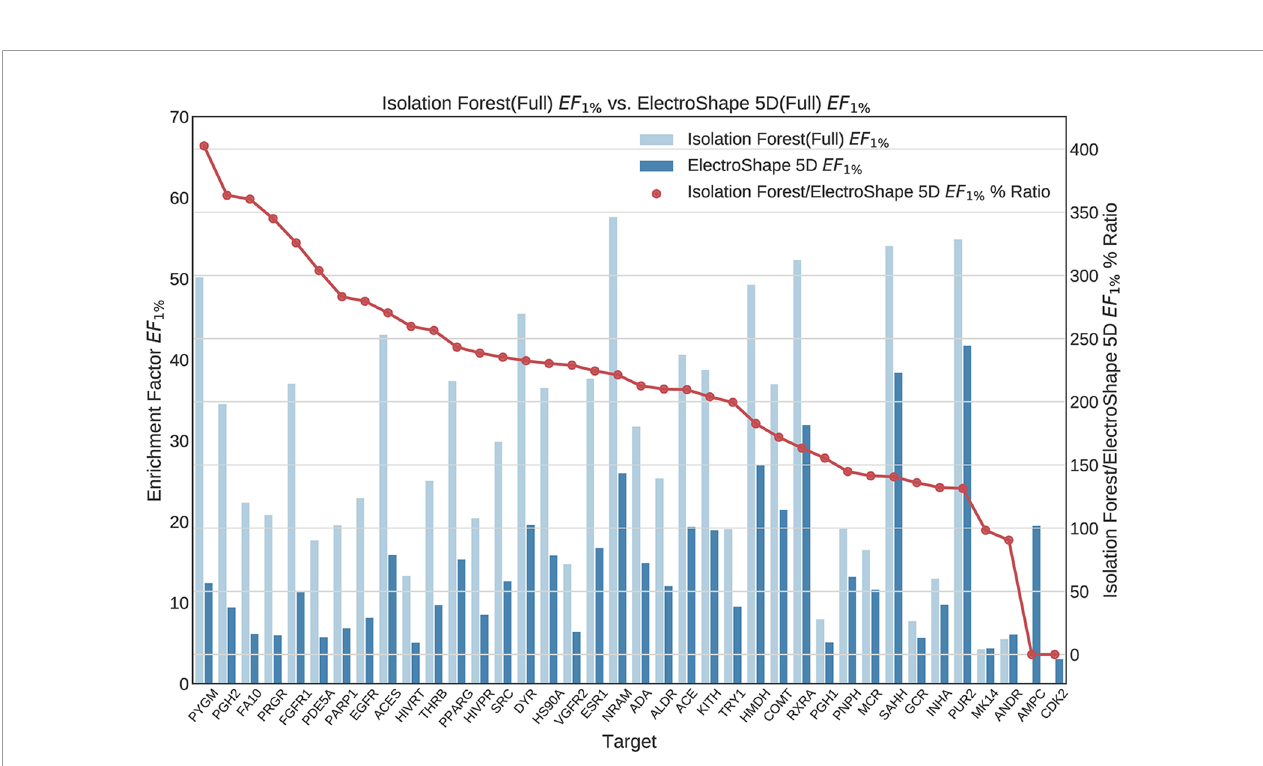
FIGURE 7 | Comparison of Enrichment Factor at 1% obtained by Isolation Forest with that obtained by ElectroShape 5D using full conformer model. Also plotted is the percentage ratio of the Enrichment Factor score of Isolation Forest compared to ElectroShape 5D. Mean ratio = 211% ± 90%, max = 941%, min =